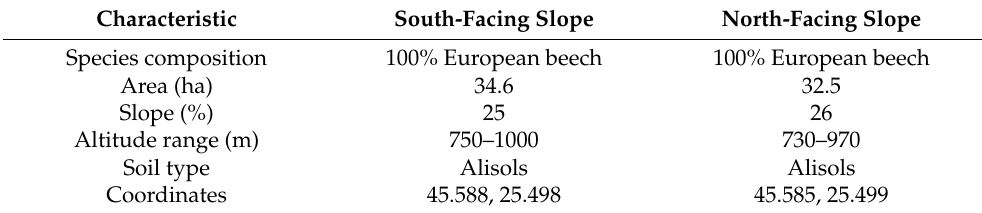
Table 1. The characteristics of the two investigated forest stands.